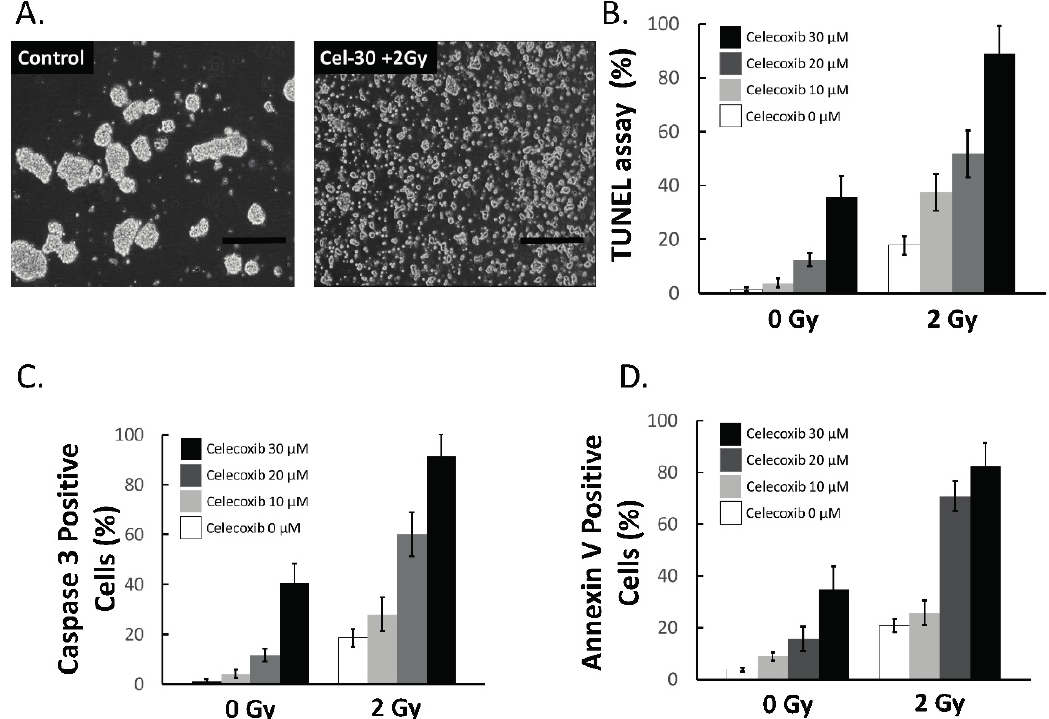
Figure 5. Celecoxib enhanced ionizing radiation-induced apoptosis in MB-DPs. ( A ) MB-DP cells (left) lose their sphere formation ability after treatment with celecoxib plus ionizing radiation (IR). Scale bar = 100 μ m; and ( B – D ) Determination of TUNEL-positive cells, Caspase 3-positive cells and Annexin V-positive cells in MB-DP cells pretreated with various doses of celecoxib with or without following IR exposure (2 Gy). Data shown here are the mean ± SD of three